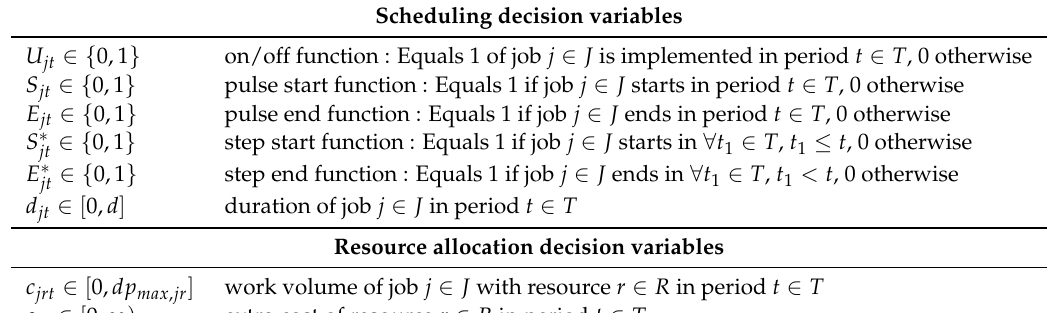
Table 2. Model nomenclature: Decision variables notations.